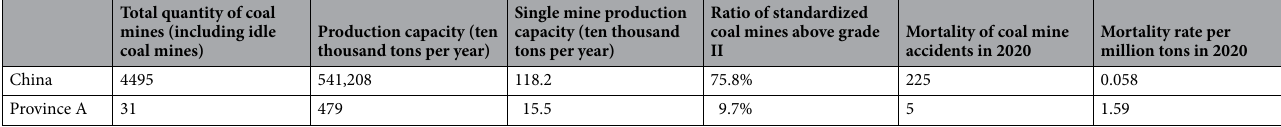
Table 1. Comparison of the safety production situation of coal mines between China and Province A